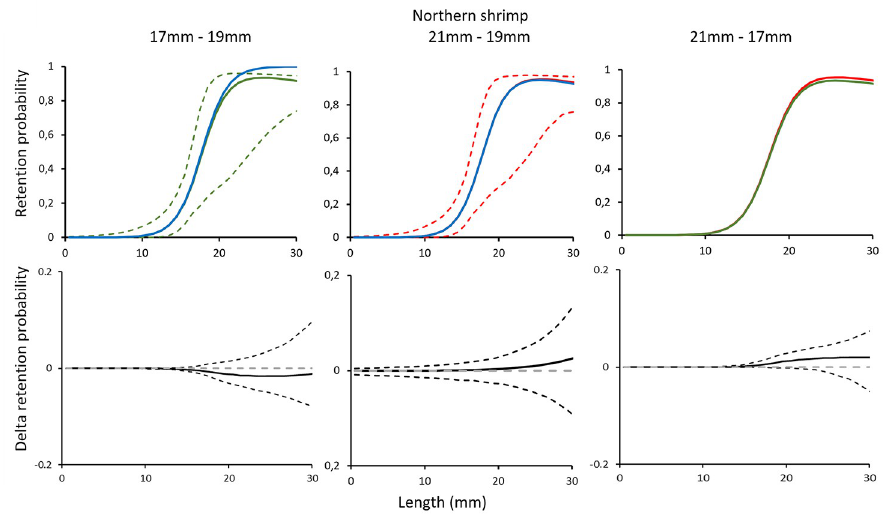
Fig 5. Combined (grid and codend) selectivity curves (a-c) and delta plots (d-f) obtained with different grid bar spacing for Northern shrimp. In plots a-c, the green curve shows results for 17 mm, blue– 19 mm, and red– 21 mm grid spacing. Stippled lines are the 95%